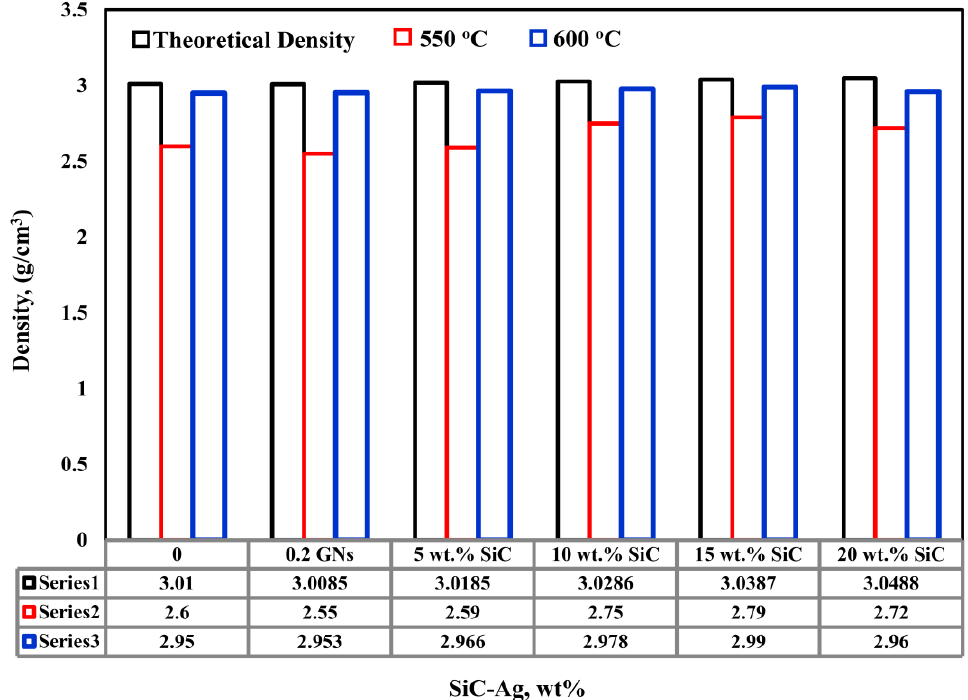
Figure 4. Density of the hybrid Al matrix reinforced with SiC-Ag.